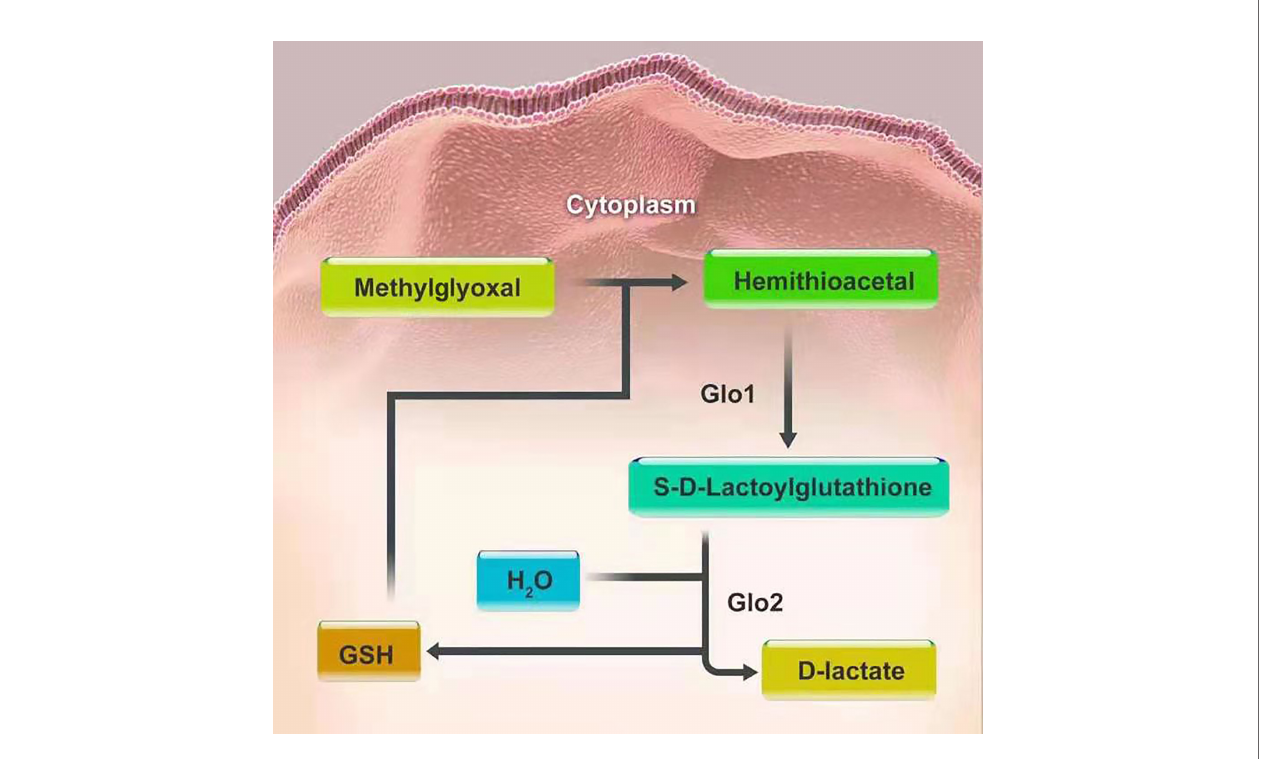
FIGURE 2 | The detoxi fi cation of